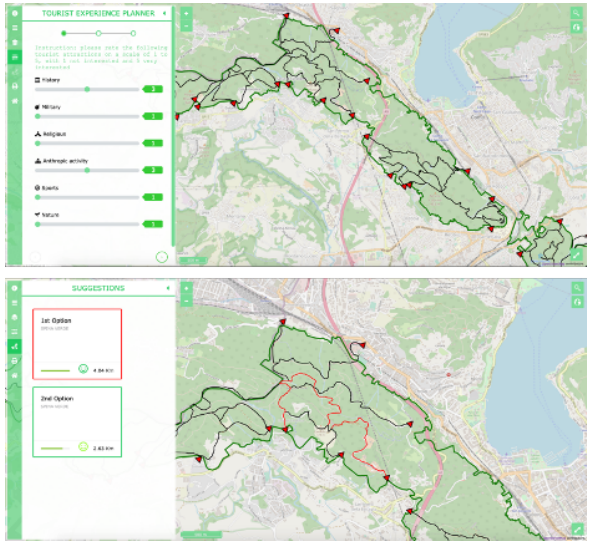
Figure 4. Tourist Experience Planner plugin included in the WebGIS of INSUBRI.PARKS: User’s preferences collection tab (top), and results rendering (down)